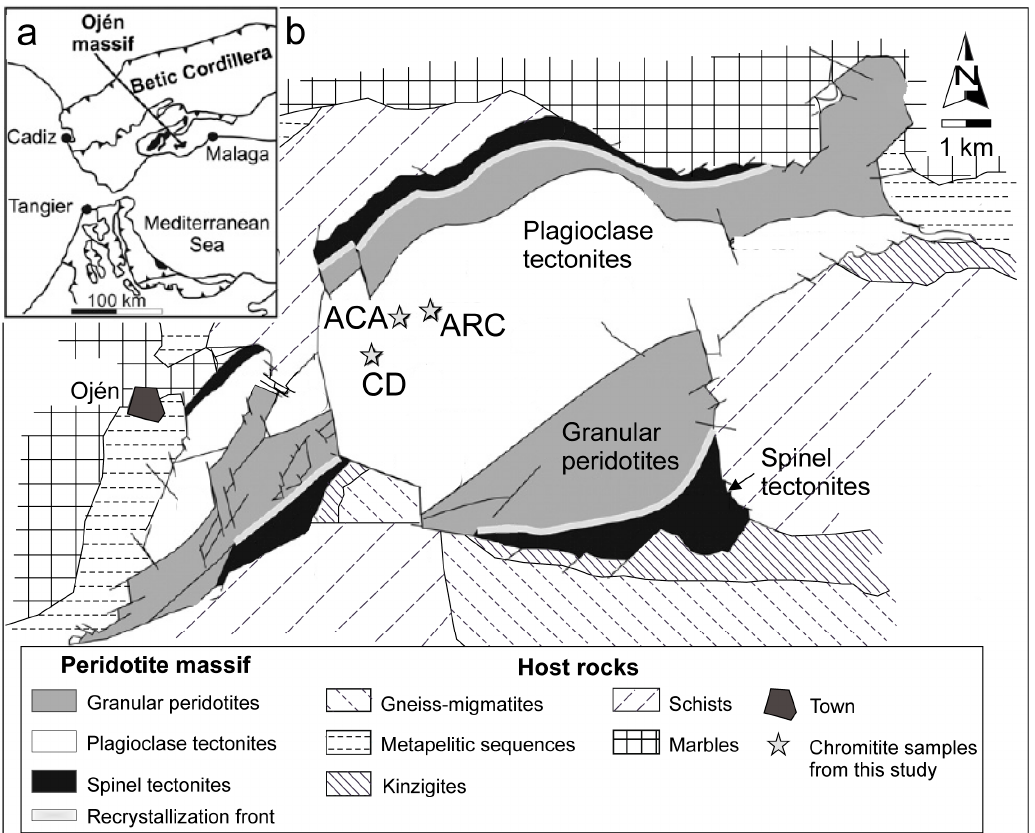
Figure 1. ( a ) Geographical situation of the ultramafic massifs located in southern Spain and in northern Morocco (in black) and ( b ) schematic map of the Ojén lherzolitic massif showing its three petrological and metamorphic domains (modified from [23,24]. The different acronyms for the chromitite bodies referred in previous works of study are ACA and ARC for Arroyo de los Caballos and CD for Cantera de Dunitas.